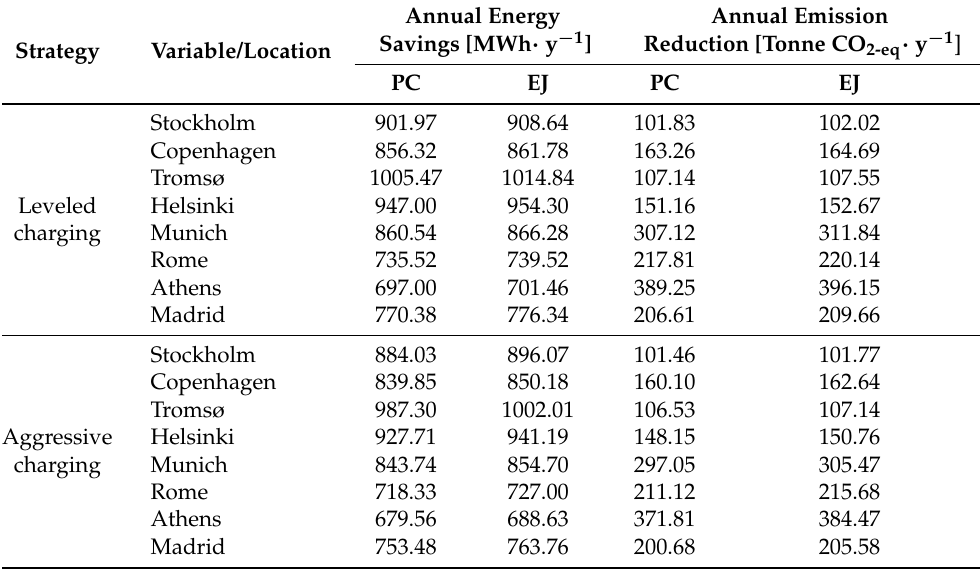
Table A1. Annual energy savings and emission reductions (TEWI) of the investigated systems in relation to the reference thermal system. The eight selected locations are listed when applying both the leveled and aggressive charging